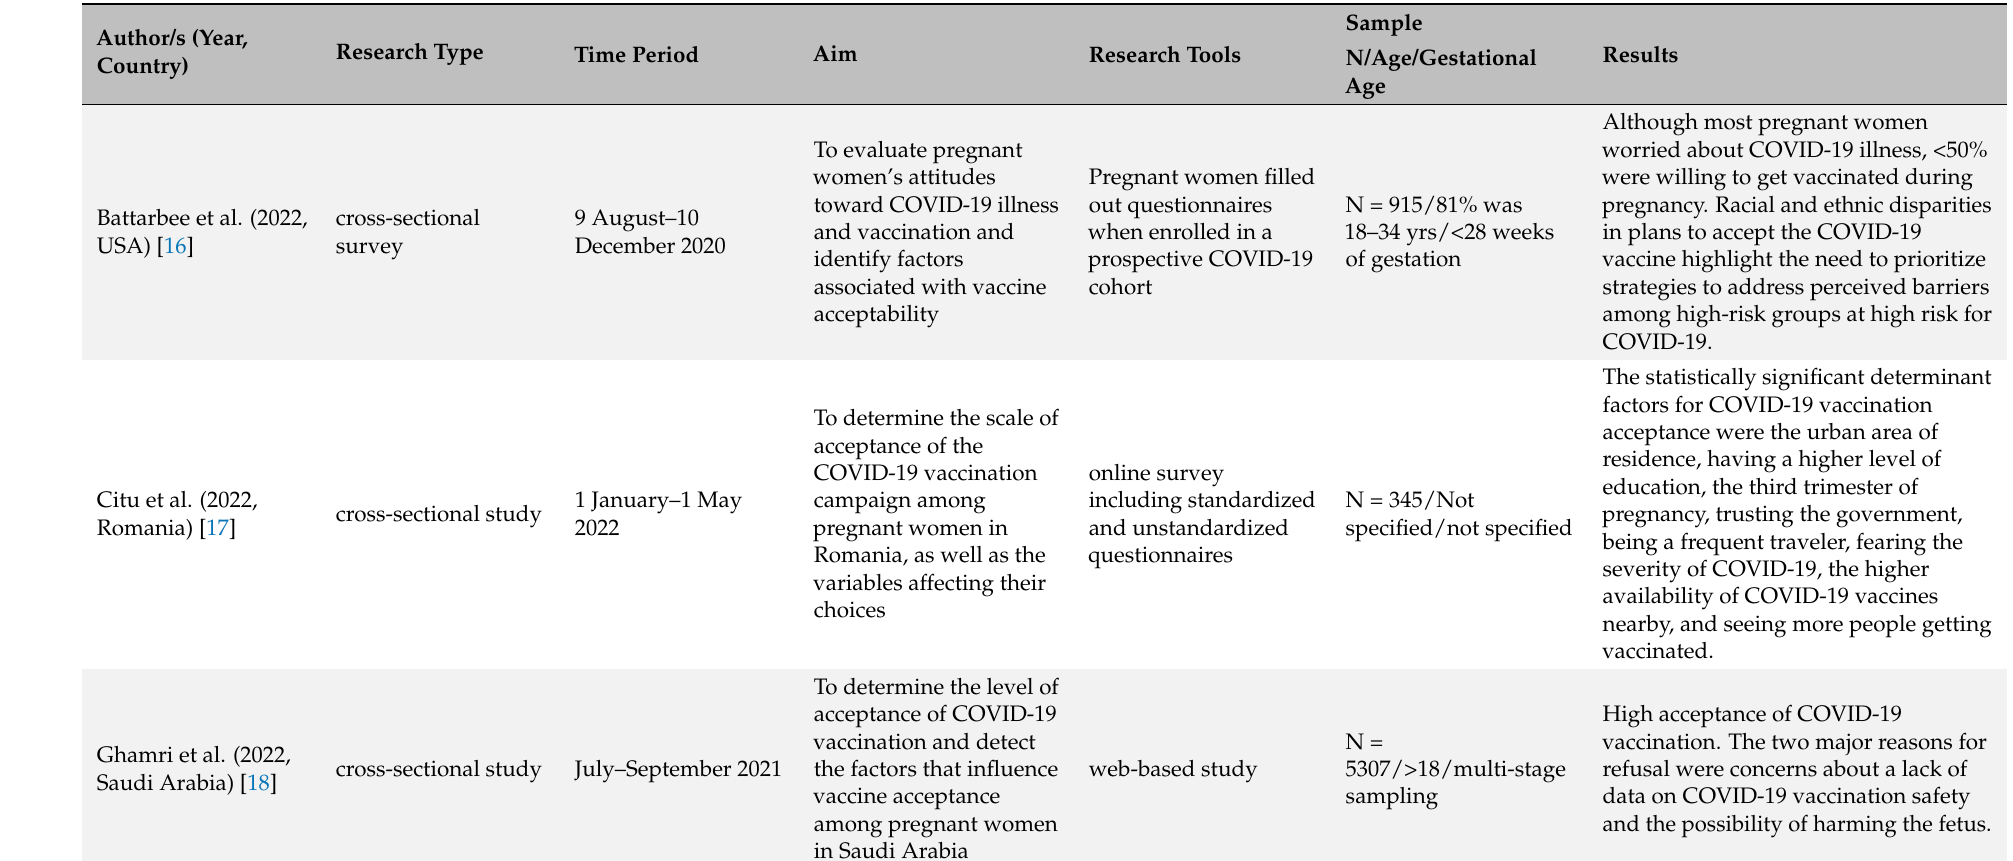
Table 1. Characteristics of studies included in review &